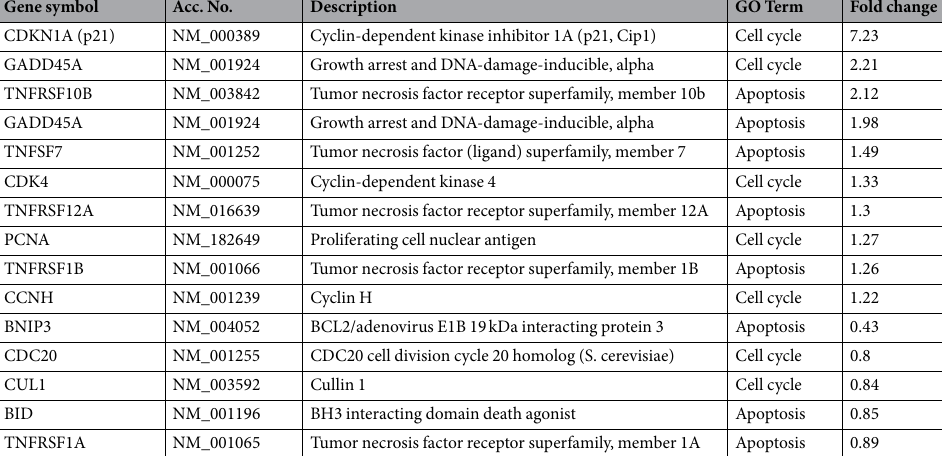
Table 1. Cell cycle and apoptosis-related genes expression fold change in U87 GBM cells treated with TMZ. Data derived from GEArray ® Human cell cycle and apoptosis microarray by hybridizing cDNA synthesized from total mRNA derived from U87 cells treated with or without TMZ (25 μ